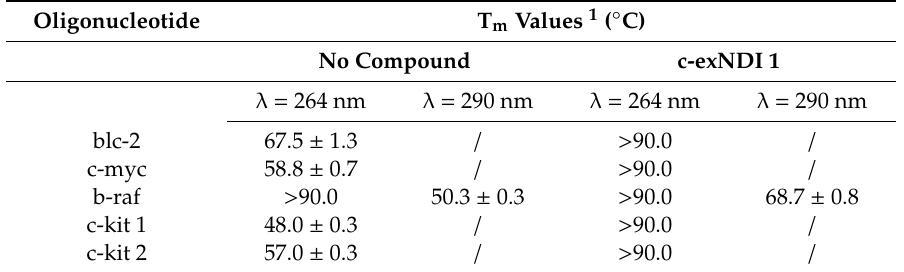
Table 2. Stabilization of oncogene promoter G4-folded sequences (4 µ M) by compound 1 (16 µ M), measured by CD thermal unfolding